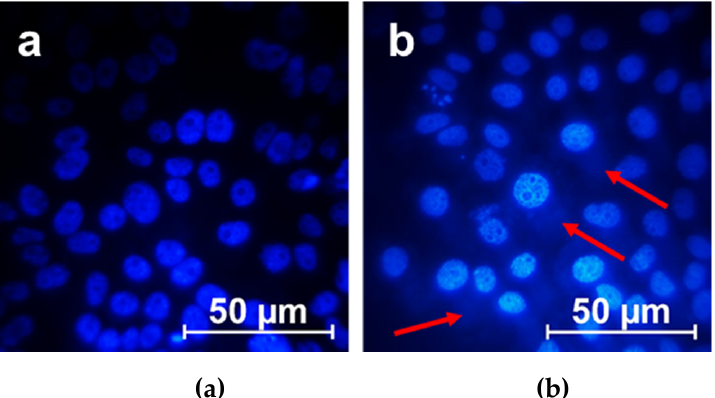
Figure 10. Fluorescent micrographs of HeLa cells in the absence ( a ) and in the presence of the IA-12/oNu complex ( b ); C oNu = 1 mM, C IA-12 = 0.5 mM. The arrow indicates the presence of oligonucleotide in the cytoplasm of cells.